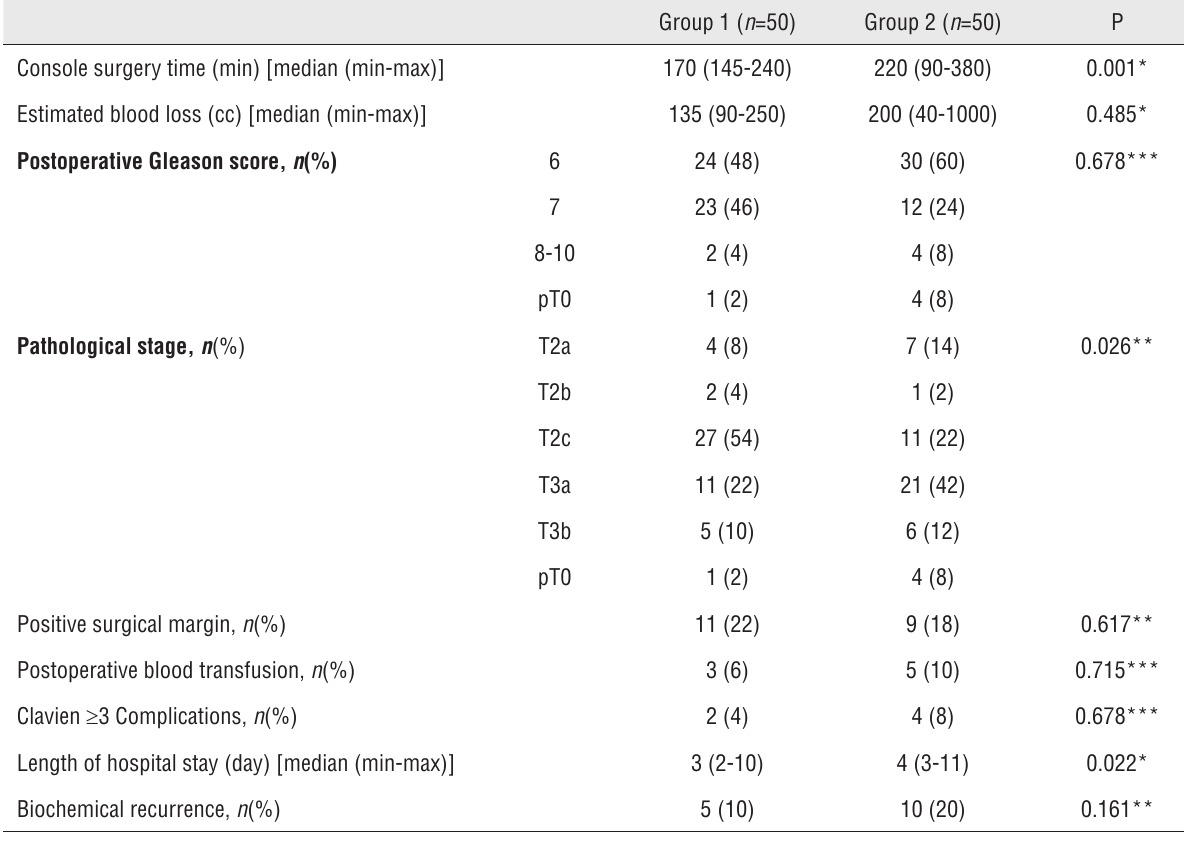
Table 2 - Comparison of peroperative and postoperative